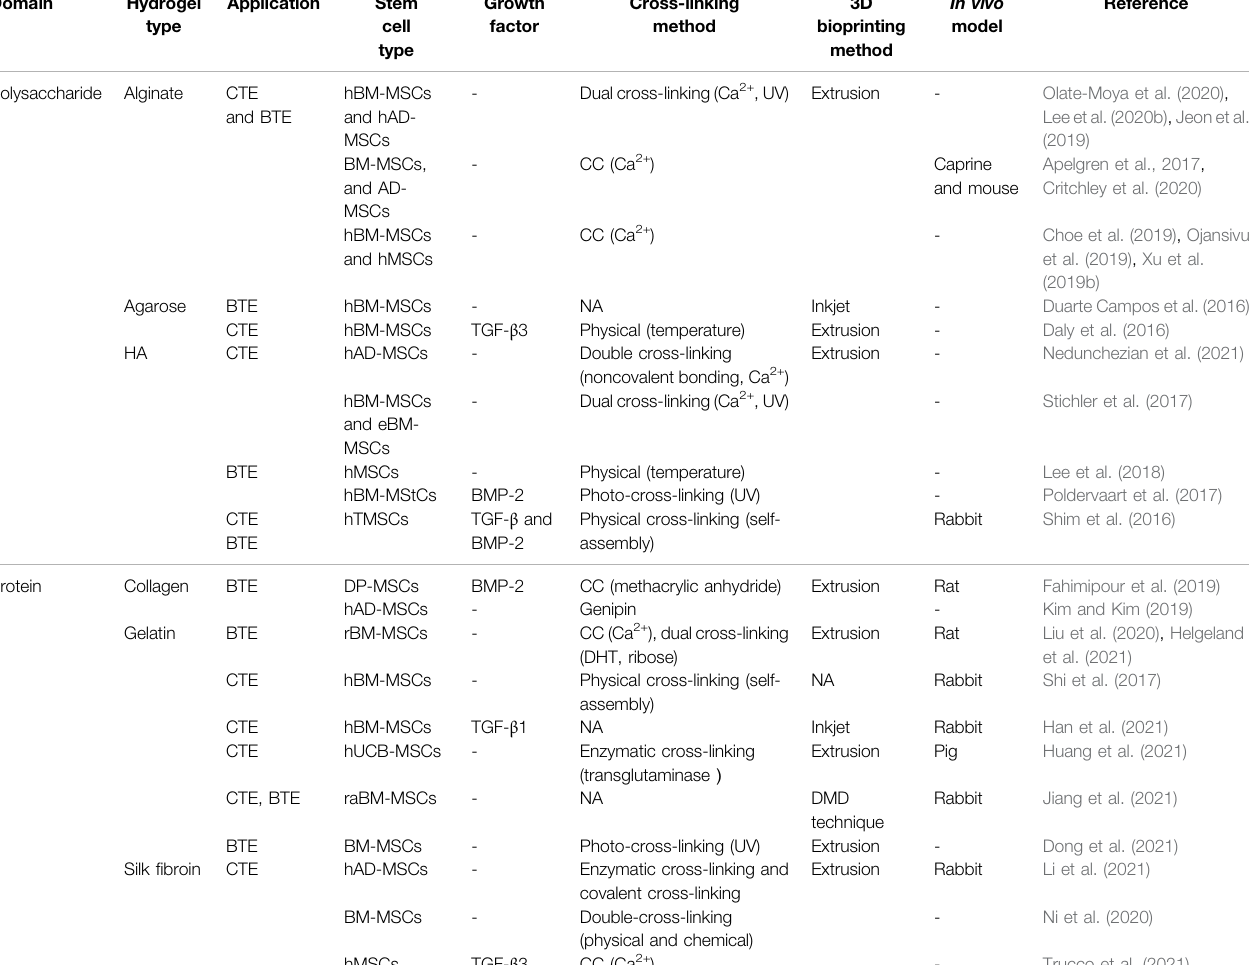
TABLE 1 | Hydrogel, stem cell, growth factor, cross-linking method, and 3D bioprinting method used for CTE and BTE.